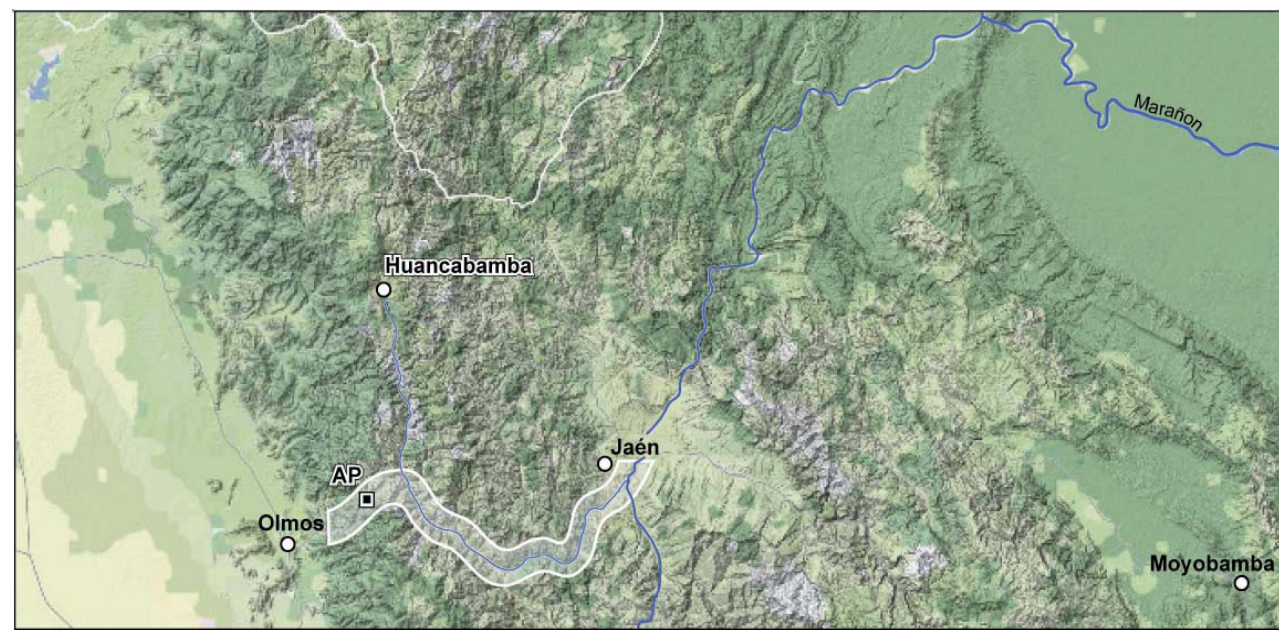
Figure 7: The central part of Andean Depression around the Rio Huancabamba, i.e. the most prominent floristic tran- sition and at the same time barrier zone between the Central and Northern Andes (whitish corridor). AP = Abra de Porculla (terrain map derived from